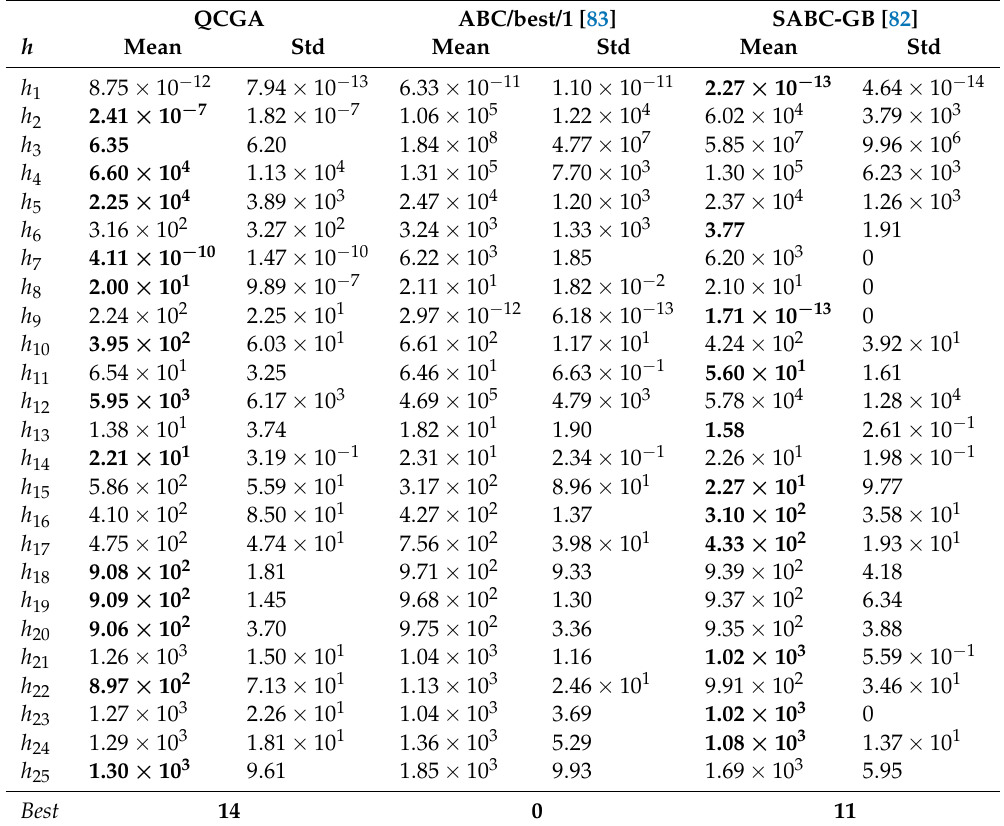
Table 11. Comparing the QCGA method with other benchmark methods using the hard functions h 1 – h 25 with dimension n = 50.